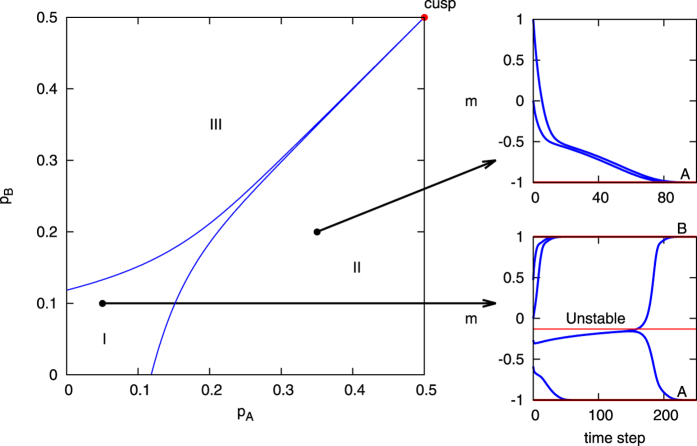
Mean-field diagram of the waning commitment naming game with two competing committed groups.The plots are calculated by the mean-field equations with commitment strength w = 10. (1) The left plot is a phase diagram containing three regions, in which the system has different fixed points. (2) The right plots show trajectories of points in regions I and II. The upper right plot is for the case where pA = 0.35 and pB = 0.2. The lower right plot is for the case where pA = 0.05 and pB = 0.1.